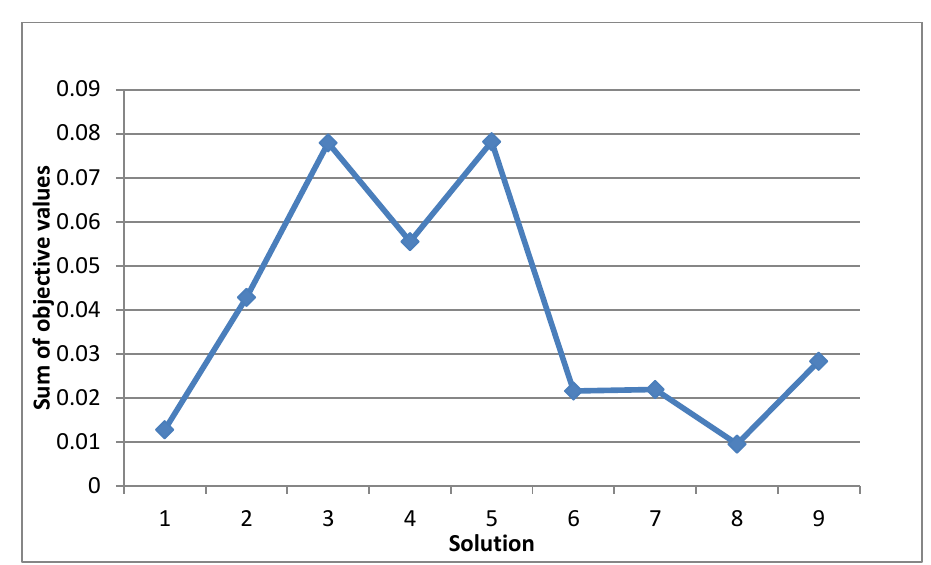
Figure 6. Summation of objective functions absolute values so obtained for all nondominated solutions